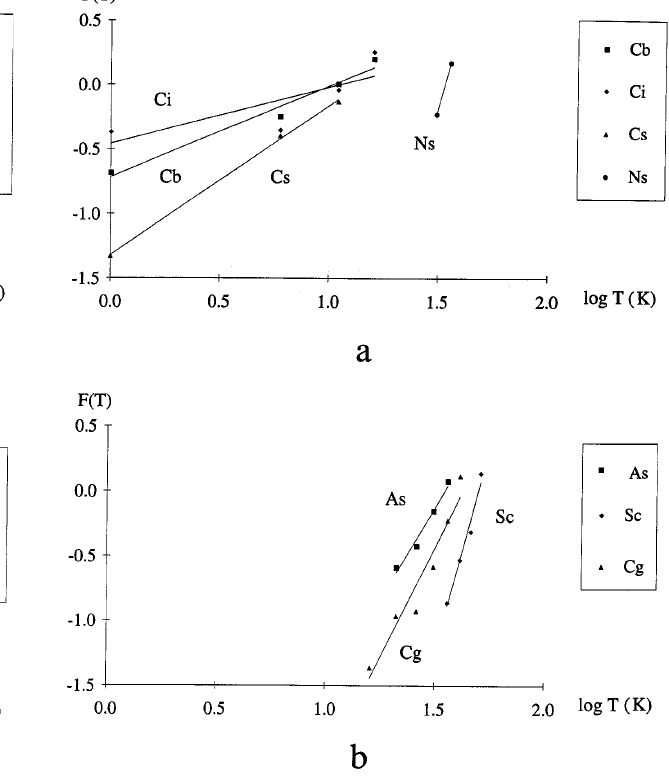
Fig. 9a, b. Cumulative frequency distributions of top temperature ( T , in K) and Weibull fitting with m (cid:136) 227: a for types Cb, Ci, Cs, Ns; b for types As,